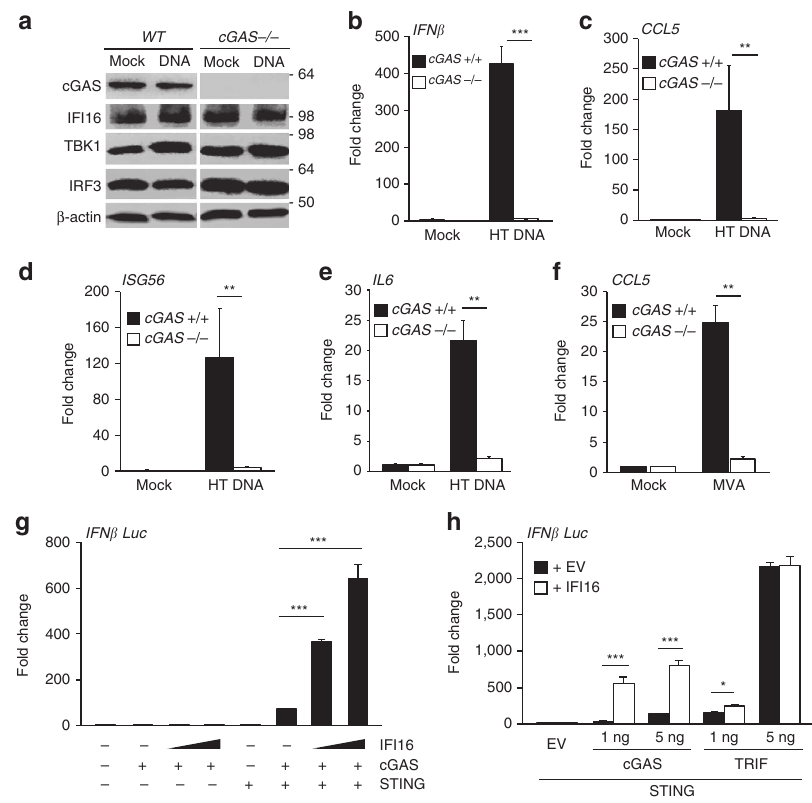
Figure 4 | cGAS is required for the innate immune response to DNA in HaCaT keratinocytes. ( a ) Immunoblot analysis of wild-type (WT) and cGAS (cid:2) / (cid:2) HaCaTcells, mock transfected or transfected with 1 m gml (cid:2) 1 HT DNA for 6h. ( b – e ) qRT-PCR analysis of cGAS þ / þ and cGAS (cid:2) / (cid:2) HaCaT cells that were mock transfected or transfected with 1 m gml (cid:2) 1 HT DNA for 6h. mRNA levels were normalized to b -actin mRNA levels and